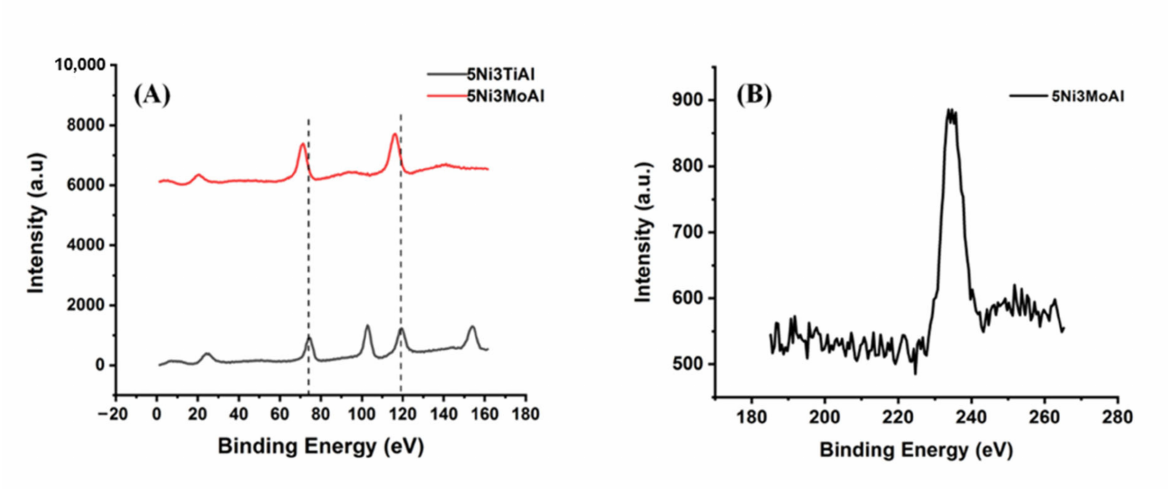
Figure 5. ( A ) Al (2p, 2s) X-ray photoelectron spectra of catalysts 5Ni3TiAl and 5Ni3MoAl and ( B ) Mo (3d) X-ray photoelec- tron spectrum of